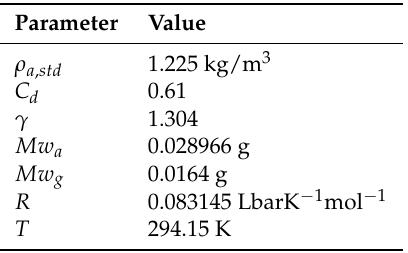
Table 1. Additional parameters and